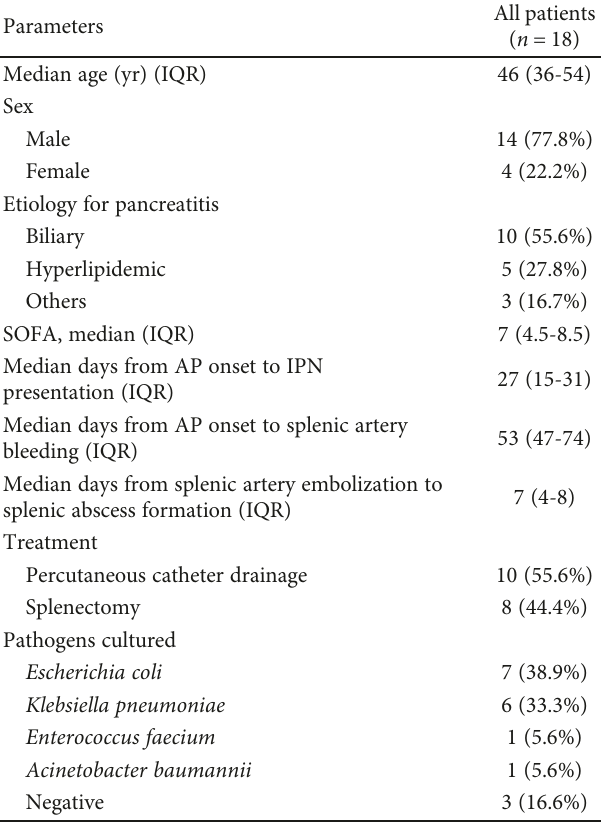
Figure 1: The fl ow chart of patients with severe acute pancreatitis. Table 1: Baseline characteristics and clinical features of patients with splenic abscess after splenic arterial